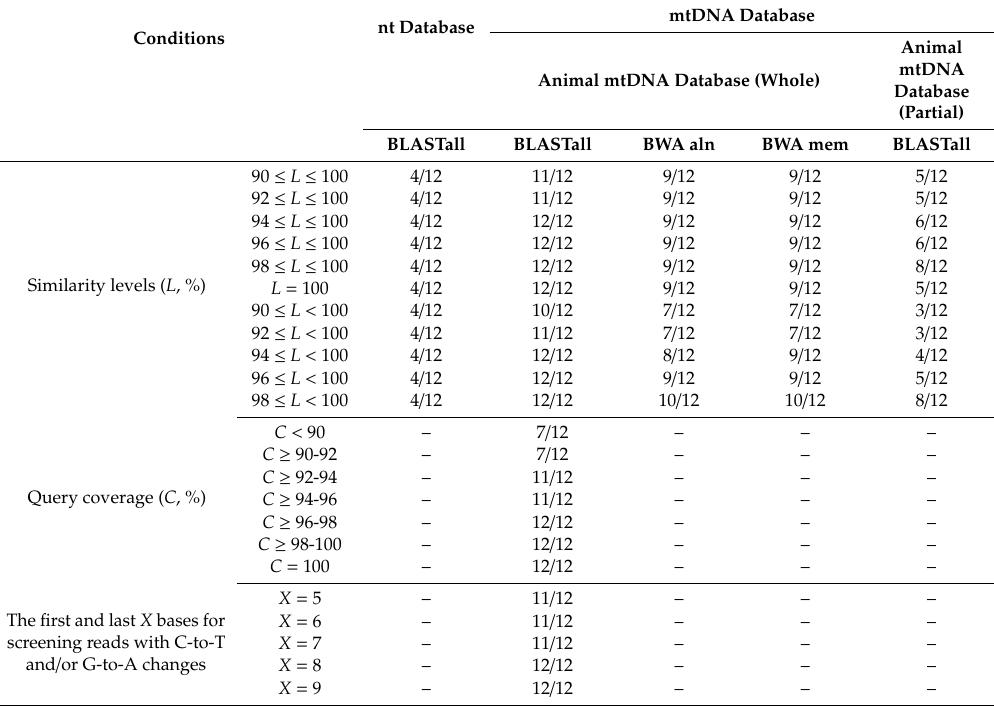
Table 2. Success rate of ancient species identification under di ff erent conditions.